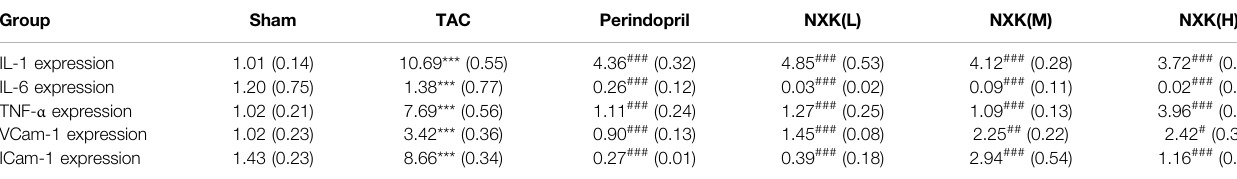
Quanti fi cationwasperformedafternormalizationto β -actin.Comparedtotheshamgroup* p < 0.05,** p < 0.01,*** p < 0.001.ComparedtotheTacgroup# p < 0.05,## p < 0.01,### p < 0.001.